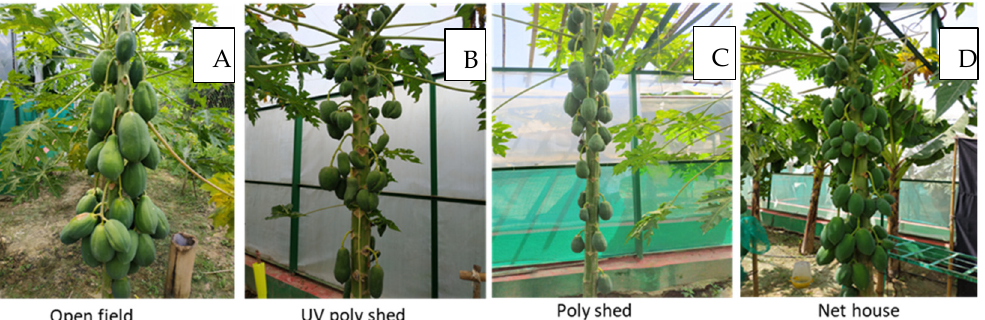
Figure 4: Papaya fruits grown under different shed houses. Open field ( A ), UV poly shed ( B ), Poly shed ( C ) and Net house ( D )